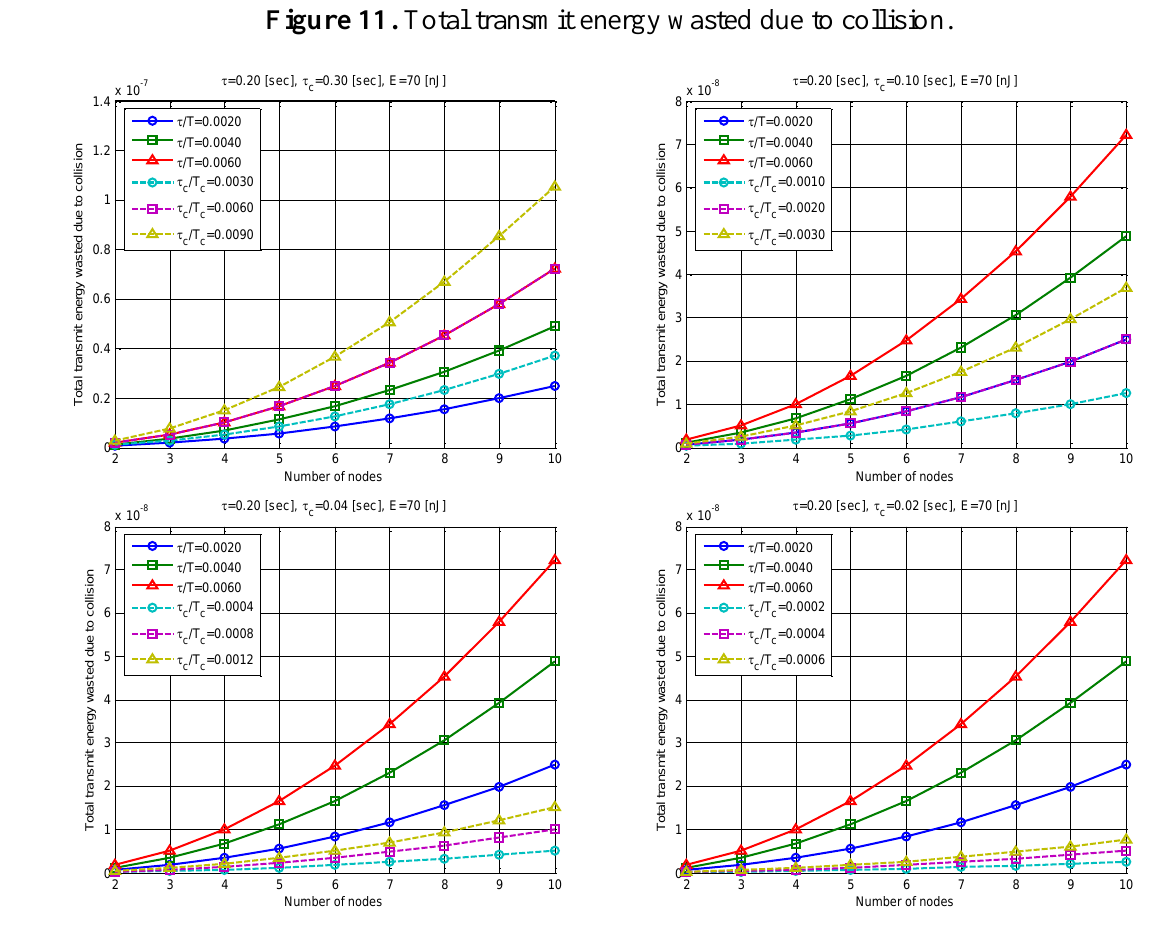
Figure 11. Total transmit energy wasted due to collision.